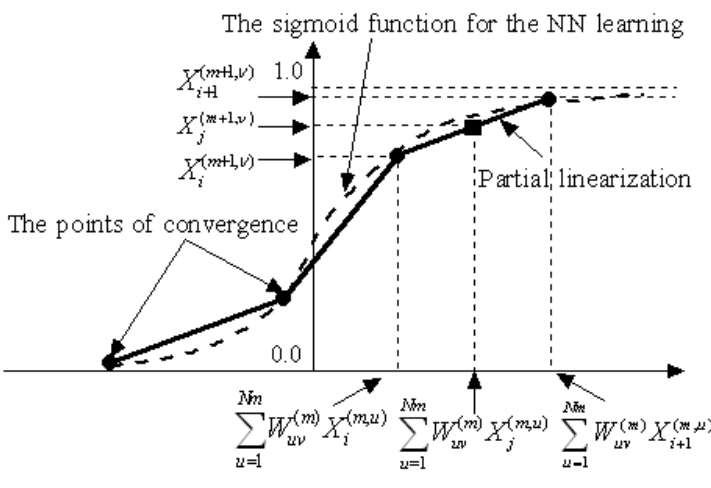
Figure 9. The partial linearization of the sigmoid